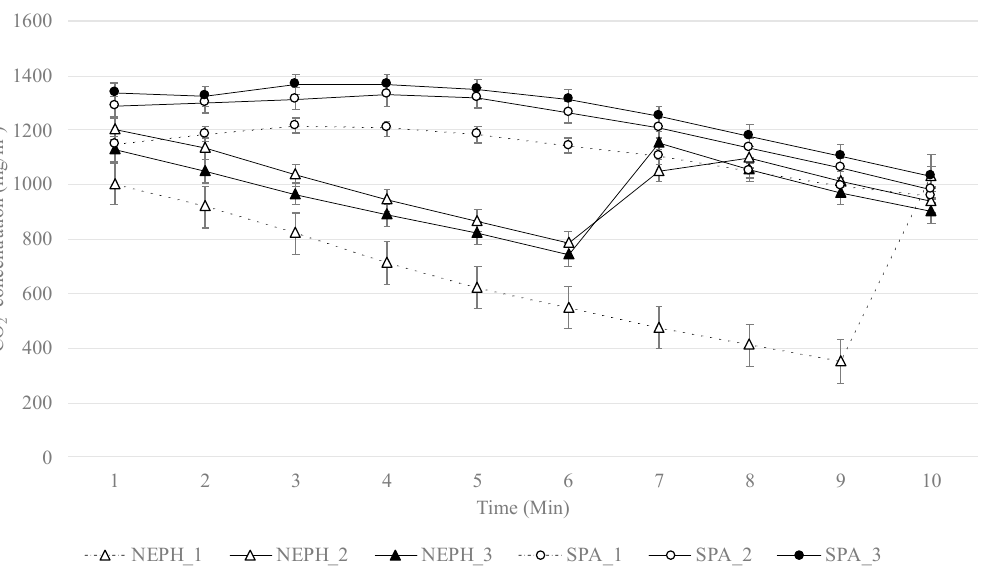
Figure 8. Depletion of CO 2 (mg/m 3 ): for the three Boston ferns (NEPH_1, NEPH_2, and NEPH_3) and for the three peace lilies (SPA_1, SPA_2, and SPA_3). Data means ± SE, n = 3.